Question: Author a descriptive caption for the visualization shown.
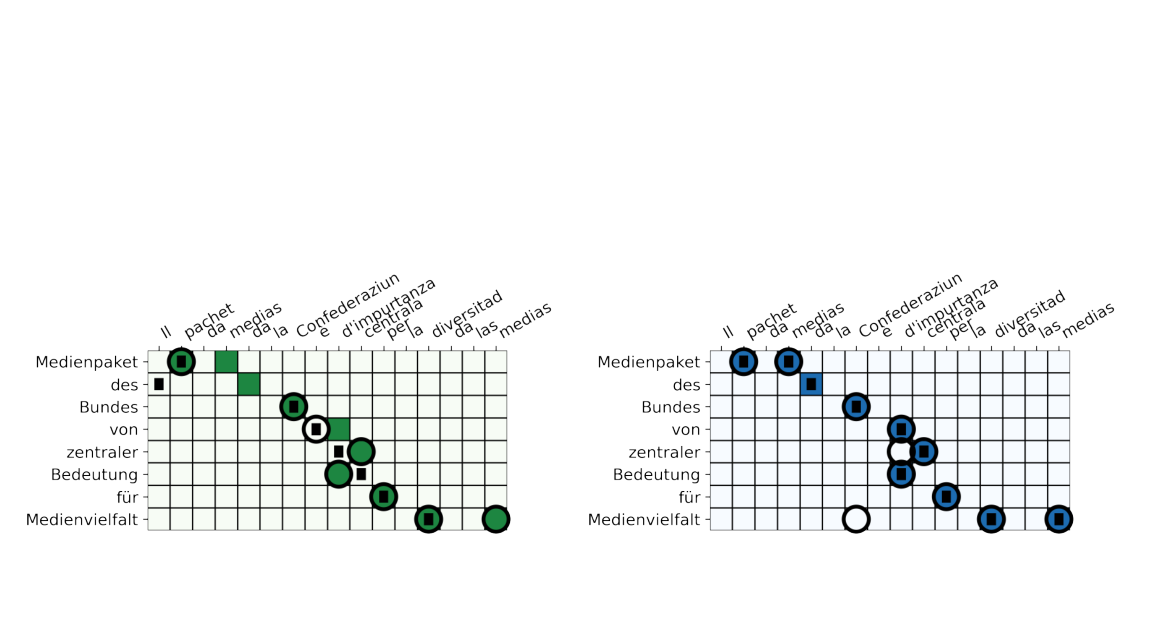
Answer: Example for aligning compounds. Green: eflomal (boxes) vs. SimAlign (circles); Blue: awesome-align (circles) vs. after fine-tuning (boxes). The dark green/blue squares represent the gold alignments.